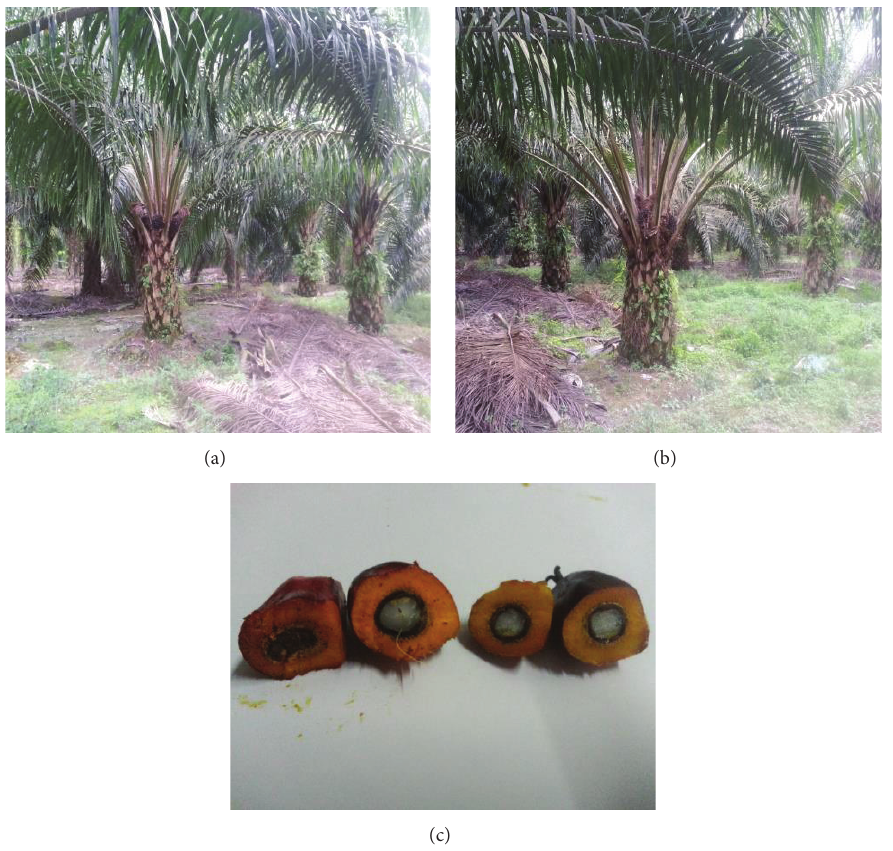
Figure 3: dura (a) and tenera (b) OPS aggregates taken from 6–9-year-old oil palm trees.